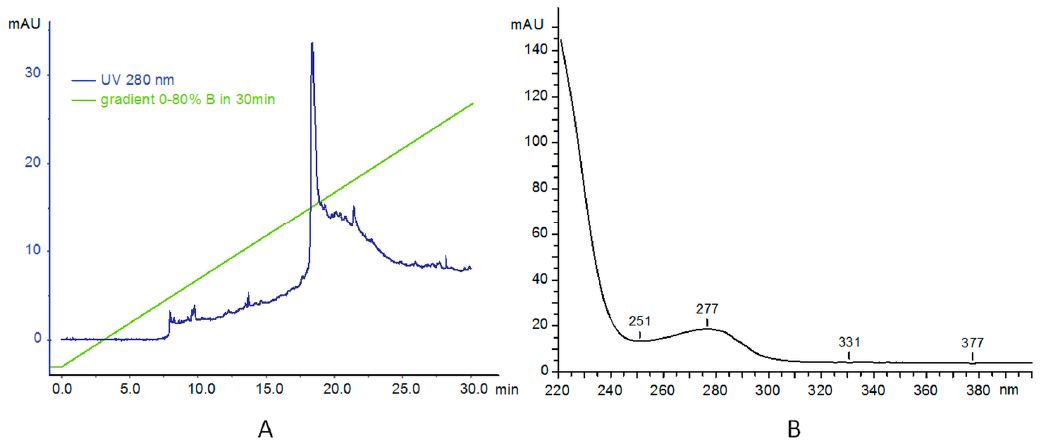
Figure 2. ( A ) RP-HPLC profile of trastuzumab; and ( B ) UV profile of the main signal at 18 min.